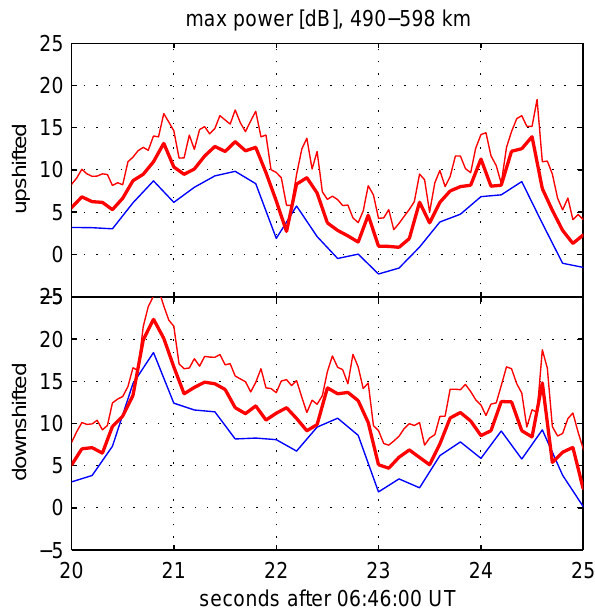
Fig. 8. Comparison of different integrations. The data is processed using three different integration periods: 50, 100 and 200ms. Then, the maximum up- and down-shifted power per unit range and unit frequency within the range interval 490–598km is extracted for each integration period, in order to obtain an idea of how the peak intensity varies with time. The 100ms curve has been raised by 3dB and the 50ms curve by 6dB, to keep them